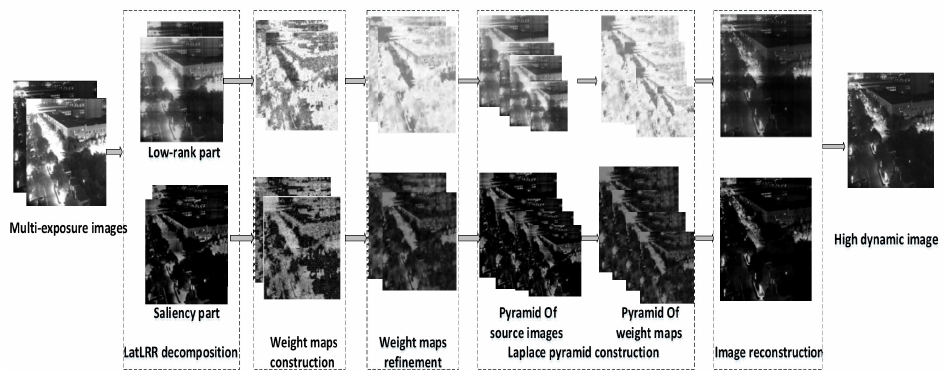
Figure 1. Framework of the proposed